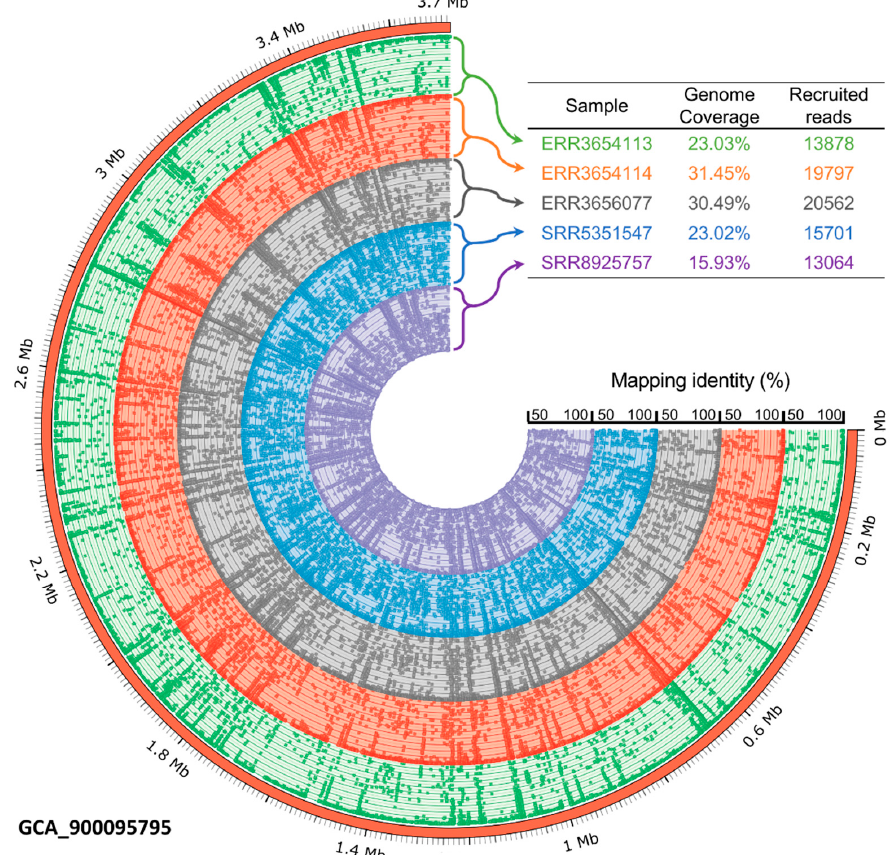
Figure 5. Fragment recruitment of publicly available metagenome sequences derived from five different mesophilic biogas ‐ producing microbial communities and mapped onto the P. mucosa ING2 ‐ E5A T genome sequence. Selected samples showing metagenome fragment mapping results of greater than 1% were visualized. The outer ring represents the P. mucosa ING2 ‐ E5A T genome in Mega base pairs (Mb), while remaining colored rings show the coverage of the mapped metagenome reads on the ING2 ‐ E5A T genome sequence. Abbreviations: GCA, genome collections accession; ERR and SRR stand for run accessions.